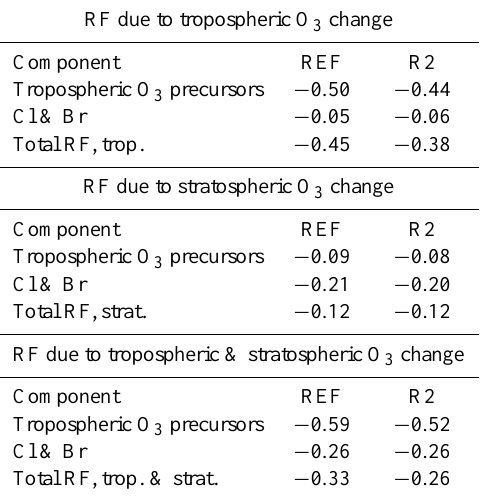
Table 6. The different components of the radiative forcing due to the change in O 3 since the pre-industrial